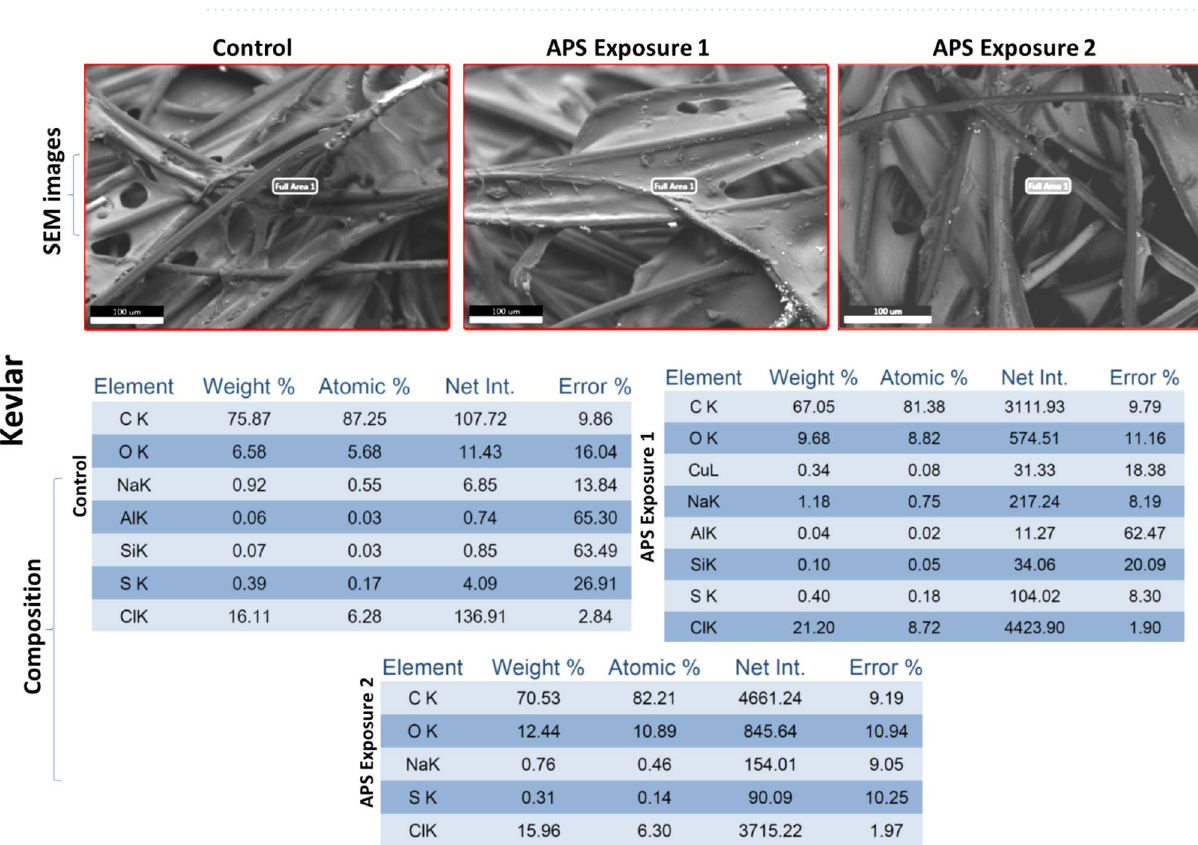
Figure 17. Material compatibility data: SEM analysis of Orthofabric with APS exposure 1: exposed to ozone CT value of 6789.02 ppm-min, and APS exposure 2: exposed to ozone CT value of 10,323 ppm-min.